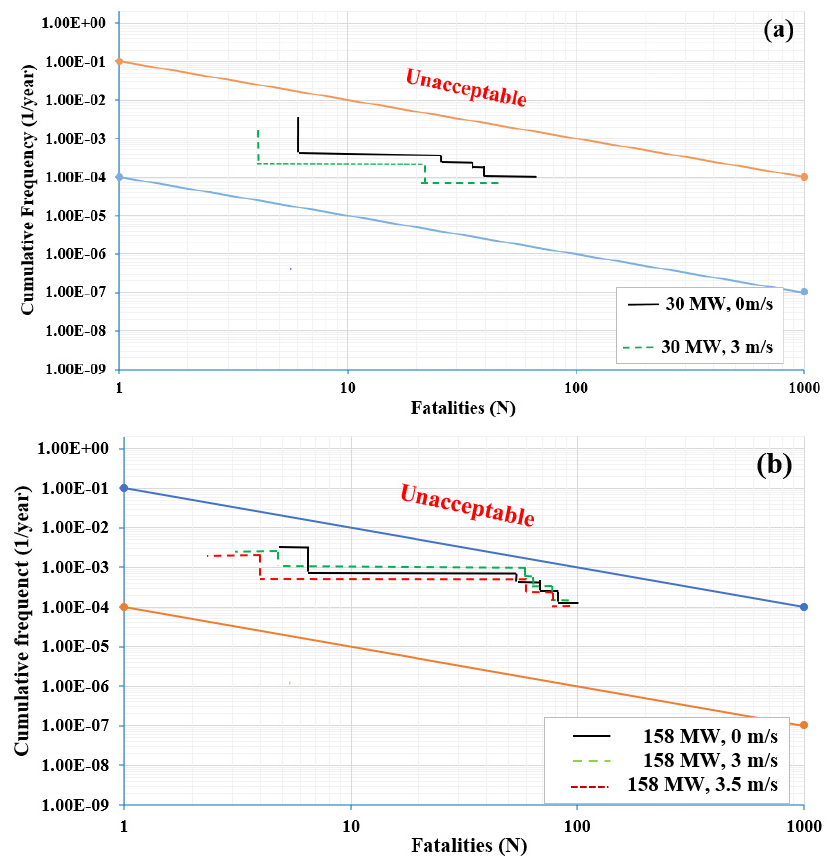
Figure 10. F/N curve for ventilation velocities 0 m/s and 3 m/s for bus fire scenarios ( a ) and 0 m/s, 3 m/s, and 3.5 m/s for HGV fire scenarios ( b ).